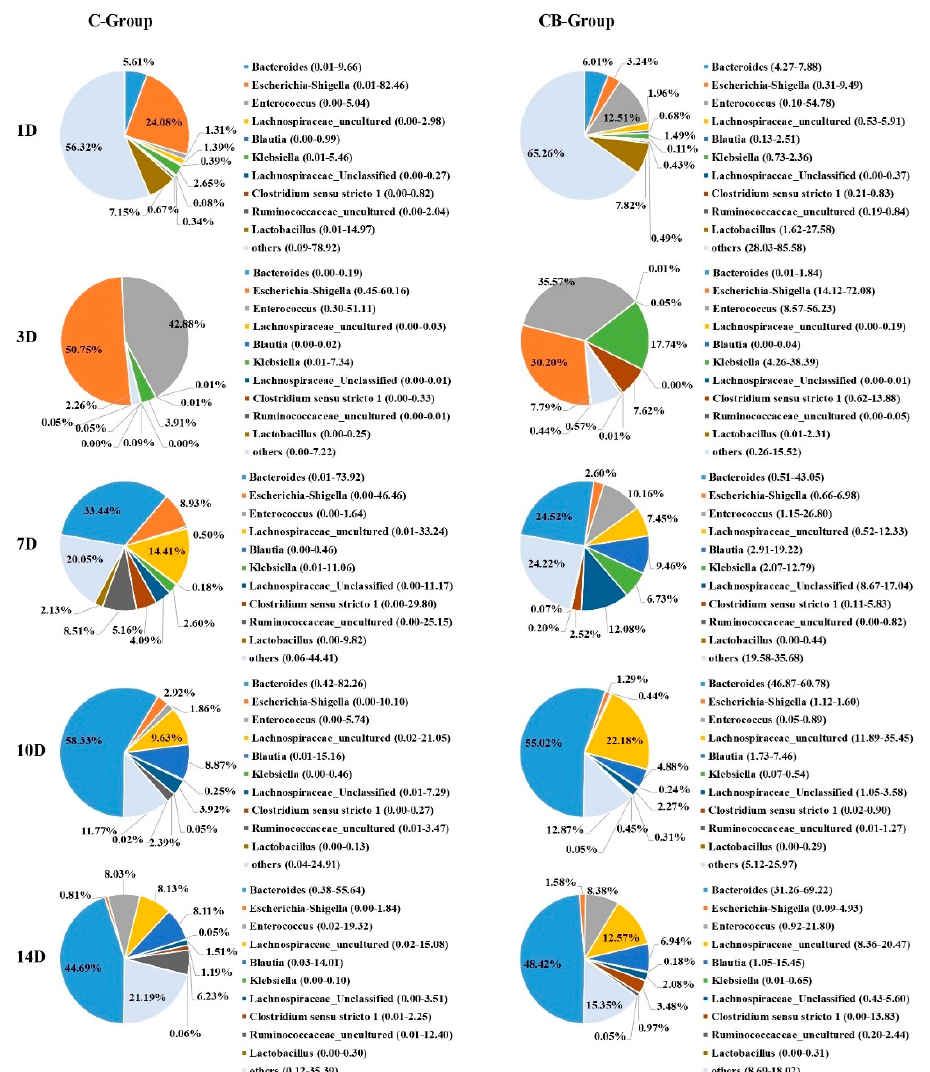
Figure 5. Genus-level bacterial composition of the cecum microbiota between the C group and the CB group. C group, control group; CB group, C. butyricum group. 1D, 3D, 7D, 10D, and 14D represent 1st day, 3rd day, 7th day, 10th day, and 14th day of the present experiment,